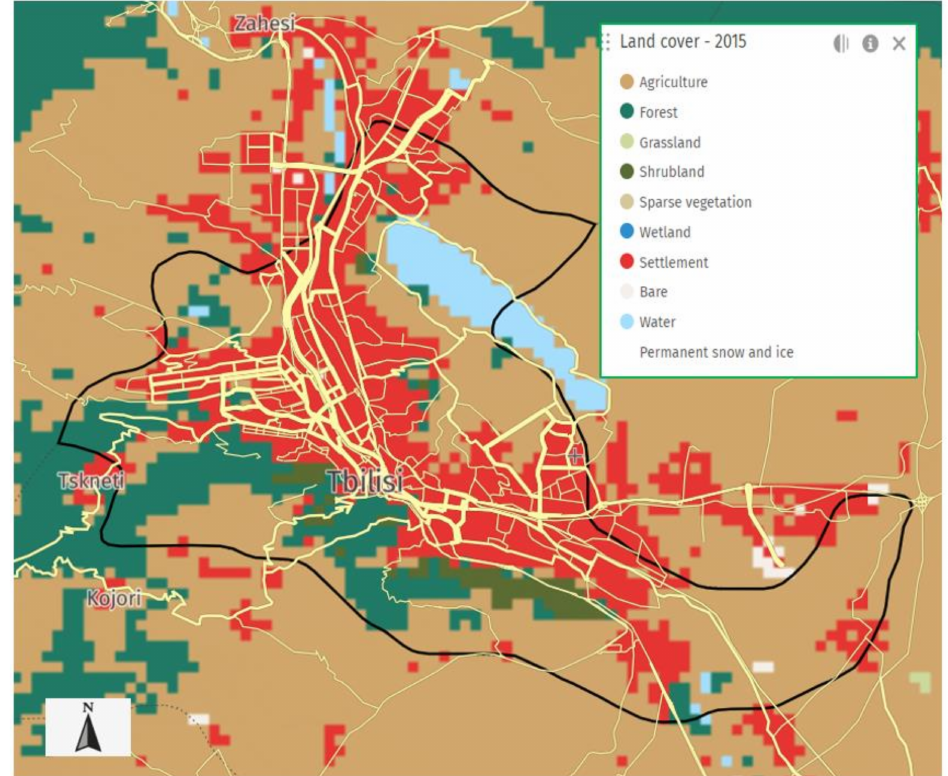
Figure 2. Schematic Map of Tbilisi Municipality, displaying land-use and land cover types (source: https://www.globalforestwatch.org, accessed on 22 November 2022)